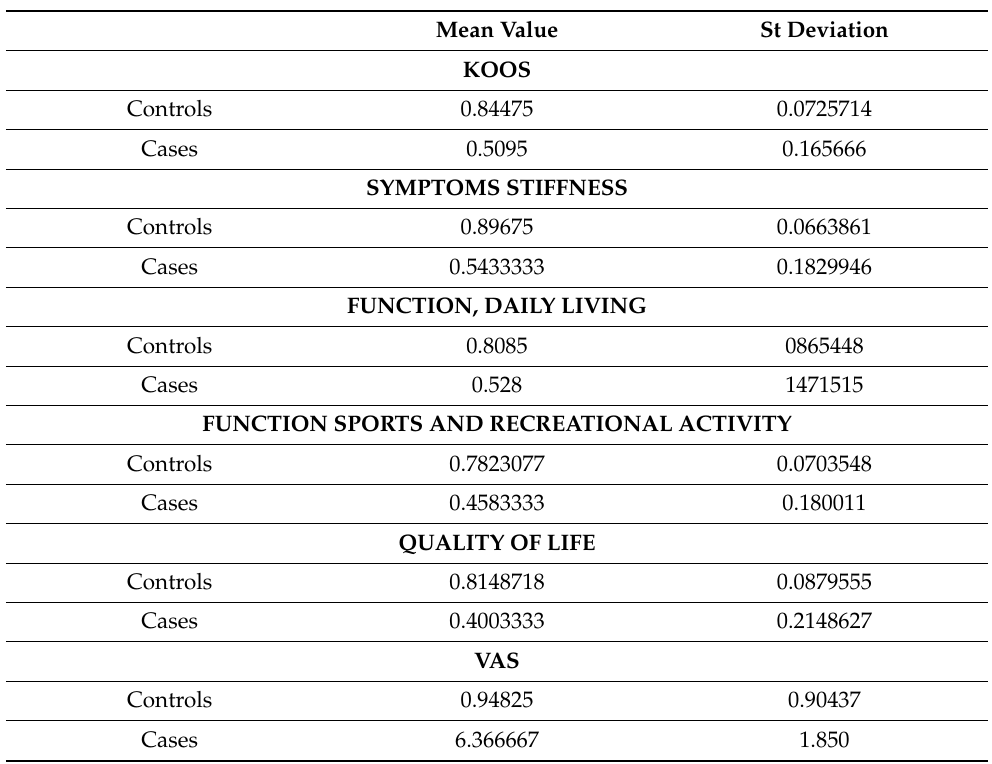
Table 6. Student’s t -test to compare media values of all clinical data in cases and controls. All media values are statistically